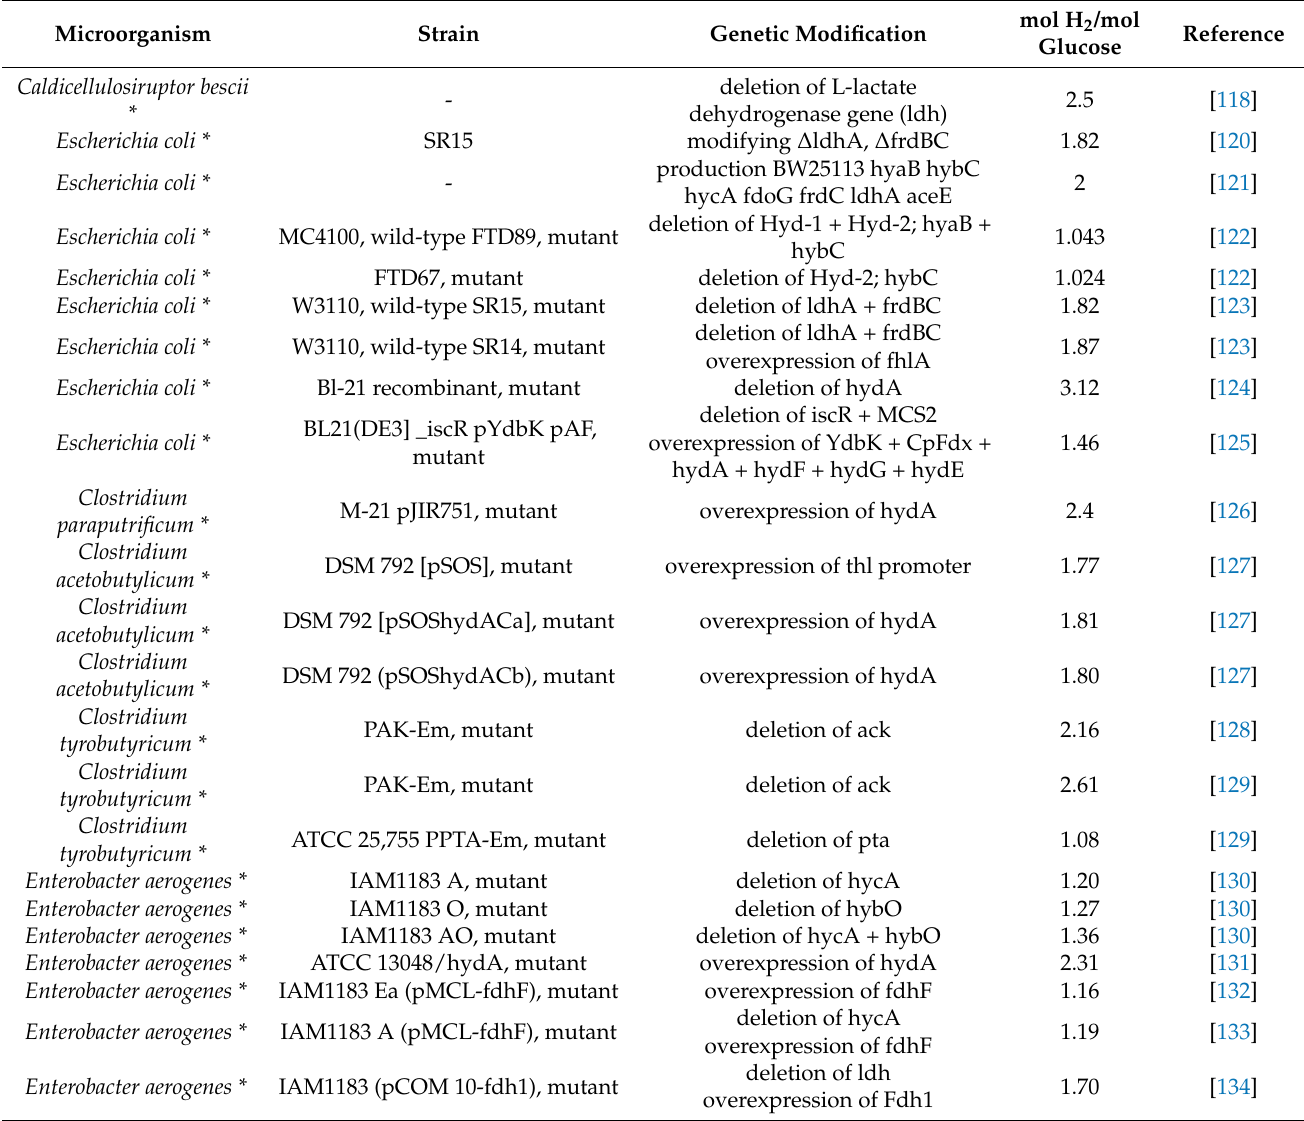
Table 4. Effect of genetic modification in various species of bacteria on hydrogen efficiency in